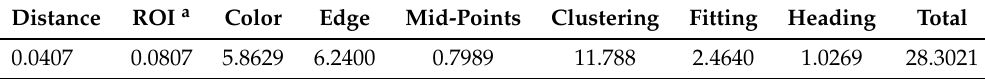
Table 5. Computational time for each task in milliseconds.